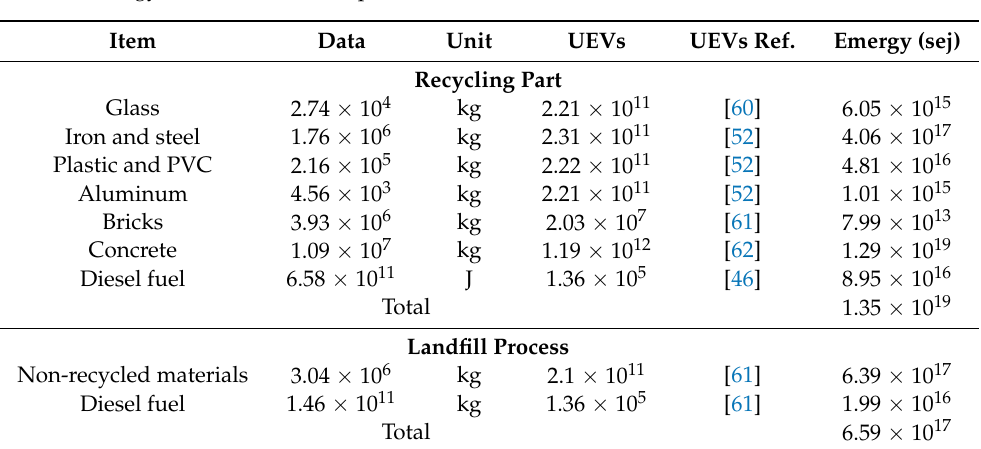
Table 5. Emergy table of demolition